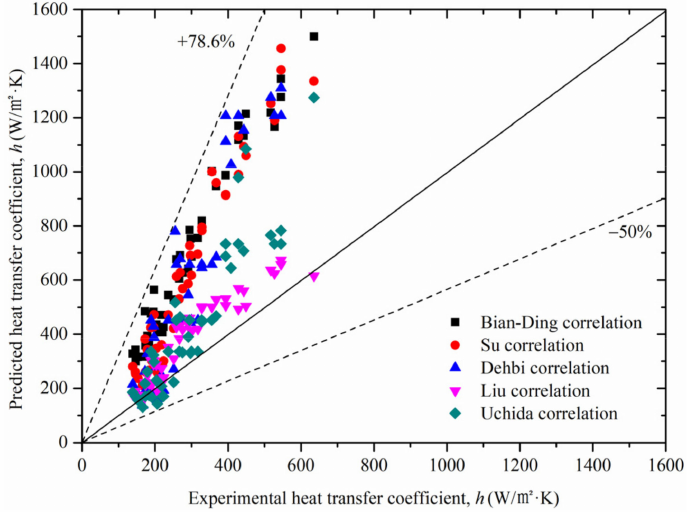
Figure 4. Comparison of previous correlation against experimental